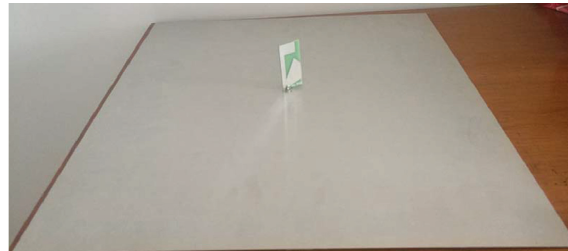
Figure 9: The two-branch vehicle